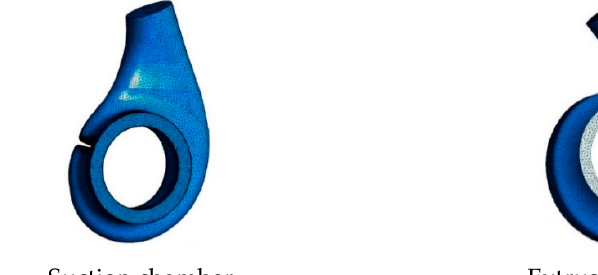
Figure 3. Mesh generation of suction chamber and extrusion chamber.